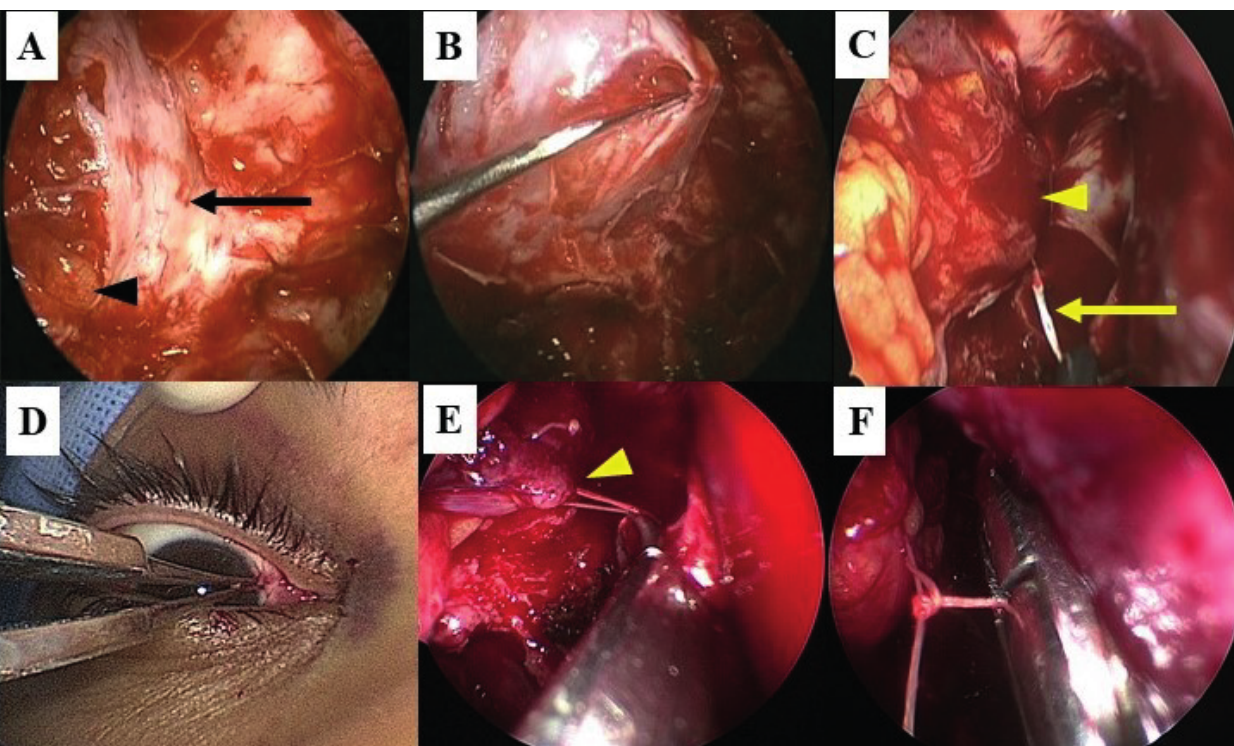
Figure 3. Endonasal approach on the right nasal cavity. A. Periorbita (black arrow) and periorbital fat (black arrowhead) evidencing perirbital injury from previous ESS surgery; B. Incision and dissection of the residual periorbita; C. Exposure and insertion of a single suture in the anterior end of the proximal MRM stump (yellow arrowhead) and suture needle (yellow arrow); D. Medialization of the orbit to facilitate approximation of distal and proximal stumps; E. Approximation of the distal MRM stump (yellow arrowhead) in the nasal cavity; F. Both ends of the ruptured MRM were